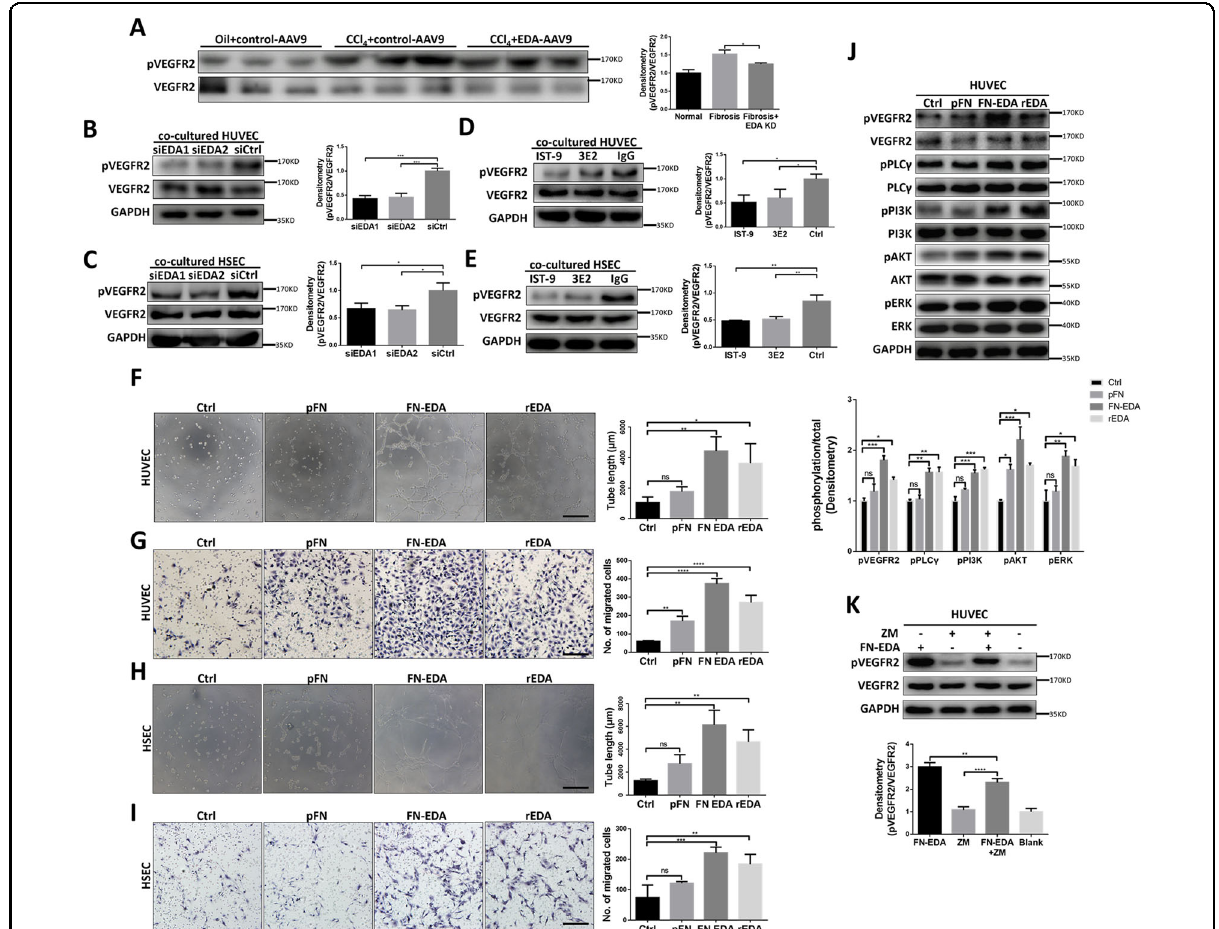
Fig. 3 FN-EDA promoted phosphorylation of VEGFR2 in vivo and vitro. A Immunoblot result of pVEGFR2 and total VEGFR2 in AAV9-FN-EDA- shRNA or AAV9-Ctrl infected mice with experimental hepatic fi brosis ( n = 3). (Data are shown as mean ± SEM; * P < 0.01.) B , C Immunoblot result of pVEGFR2 in HUVECs and HSECs co-cultured with FN-EDA-siRNAs or Ctrl-siRNA transfected LX-2 cells for 8 h ( n = 3). (Data are shown as mean ± SEM; HUVEC: EDA-siRNA1 versus Ctrl, *** P < 0.0001; EDA-siRNA2 versus Ctrl, ** P < 0.0001; HSEC: EDA-siRNA1 versus Ctrl, * P < 0.01; EDA-siRNA2 versus Ctrl, * P < 0.01.) D , E Immunoblot result of pVEGFR2 in HUVECs and HSECs co-cultured with LX-2 for 8 h. LX-2 were pretreated with neutralizing antibodies IST-9 or 3E2 or mouse IgG (40 μ g/ml) for 0.5 h ( n = 3). (Data are shown as mean ± SEM; HUVEC: IST-9 versus Ctrl, * P < 0.01; 3E2 versus Ctrl, * P < 0.01; HSEC: IST-9 versus Ctrl, ** P < 0.001; 3E2 versus Ctrl, ** P < 0.001.) F Tube formation assay of HUVECs treated with pFN, FN-EDA or rEDA (40 μ g/ml) for 6 h ( n = 3). (Data are shown as mean ± SEM; rEDA versus Ctrl: * P < 0.01; FN-EDA versus Ctrl: ** P < 0.001; pFN versus Ctrl: ns. Scale bar = 100 μ m.) G Migration assay of HUVECs treated with pFN, FN-EDA or rEDA (40 μ g/ml) for 24 h. (Data are shown as mean ± SEM, n = 3. rEDA versus Ctrl: **** P < 0.00001; FN-EDA versus Ctrl: **** P < 0.00001; pFN versus Ctrl: ** P < 0.001. Scale bar = 100 μ m.) H Tube formation assay of HSECs treated with pFN, FN- EDA or rEDA (40 μ g/ml) for 6 h ( n = 3). (Data are shown as mean ± SEM; rEDA versus Ctrl: ** P < 0.001; FN-EDA versus Ctrl: ** P < 0.001; pFN versus Ctrl: ns. Scale bar = 100 μ m.) I Migration assay of HSECs treated with pFN, FN-EDA or rEDA (40 μ g/ml) for 24 h. FN-EDA and rEDA signi fi cantly promote HSECs tube formation ( n = 3). (Data are shown as mean ± SEM; rEDA versus Ctrl: * P < 0.01; FN-EDA versus Ctrl: ** P < 0.001; pFN versus Ctrl: ns. Scale bar = 100 μ m.) J Immunoblot result of VEGFR2 related pathway in HUVECs treated with pFN, FN-EDA or rEDA (40 μ g/ml) for 6 h. (Data are shown as mean ± SEM; pVEGFR2: rEDA versus Ctrl: * P < 0.01; FN-EDA versus Ctrl: *** P < 0.0001; pFN versus Ctrl: ns; pPLC γ rEDA versus Ctrl: ** P < 0.001; FN-EDA versus Ctrl: ** P < 0.001; pFN versus Ctrl: ns; pPI3K rEDA versus Ctrl: *** P < 0.0001; FN-EDA versus Ctrl: *** P < 0.0001; pFN versus Ctrl: ns; pAKT rEDA versus Ctrl: * P < 0.01; FN-EDA versus Ctrl: *** P < 0.0001; pFN versus Ctrl: * P < 0.01; pERK rEDA versus Ctrl: * P < 0.01; FN-EDA versus Ctrl: ** P < 0.001; pFN versus Ctrl: ns.) K Immunoblot result of pVEGFR2 in HUVECs. HUVECs were treated with FN-EDA (40 μ g/ml) and/or ZM323881 (5 μ M) for 6 h ( n = 3). (Data are shown as mean ± SEM; FN-EDA versus FN-EDA + ZM323881, ** P < 0.001; FN-EDA + ZM versus ZM323881, **** P <